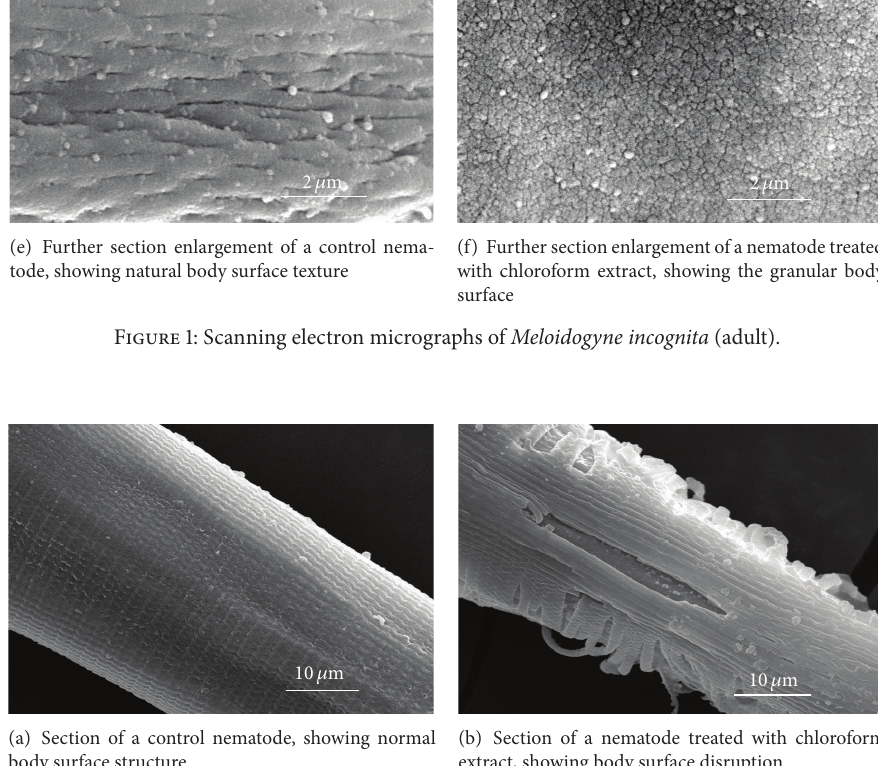
Figure 2: Scanning electron micrographs of M. incognita